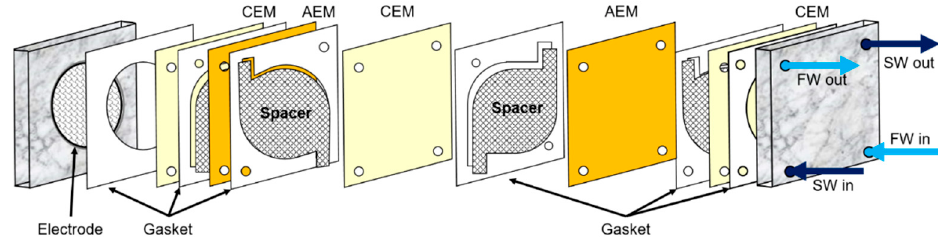
Figure 2. Schematic diagram of a bench-scale RED system. Reprinted with permission from [20]. Copyright 2018 American Chemical Society.